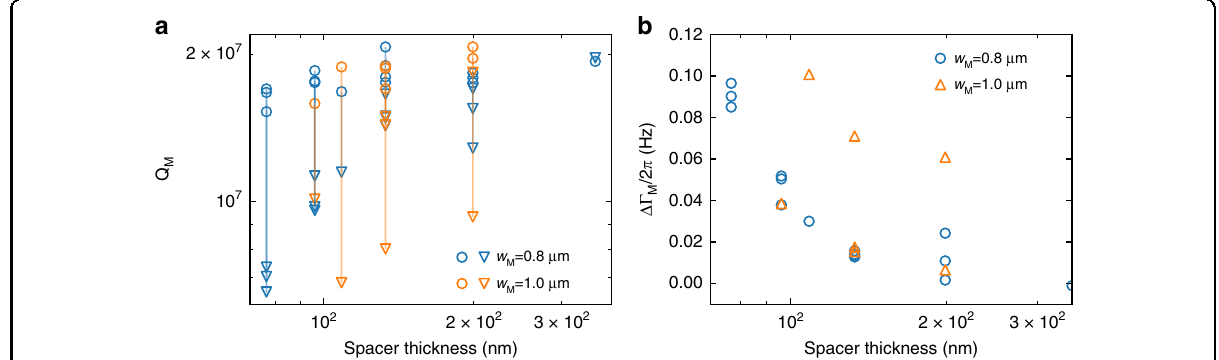
Fig. 3 Mechanical quality factor measurements. a Measured mechanical quality factor before (circle) and after (triangle) device assembly. b Dependence of the change of the mechanical damping rate Δ Γ M on the spacer thickness. A thinner spacer in general leads to a higher increase of dissipation